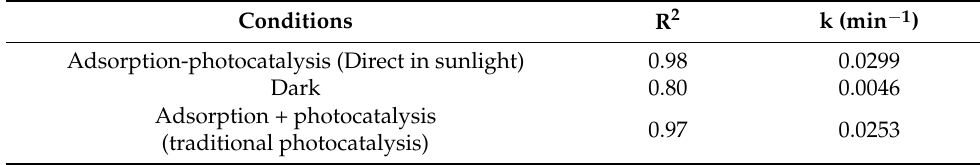
Table 1. Rate constant for the photodegradation of CVD under different